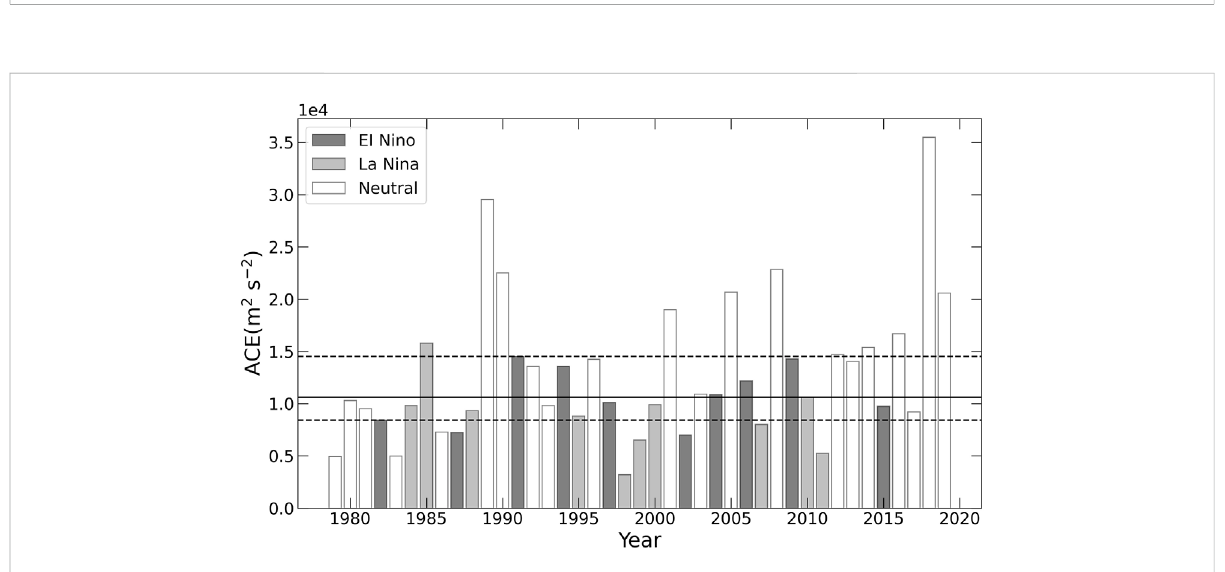
FIGURE 2 Annual variation of ACE over China mainland during May-December in the period 1979-2019. The horizontal dashed lines show the 25th and 75th percentiles, while the horizontal solid line denotes the